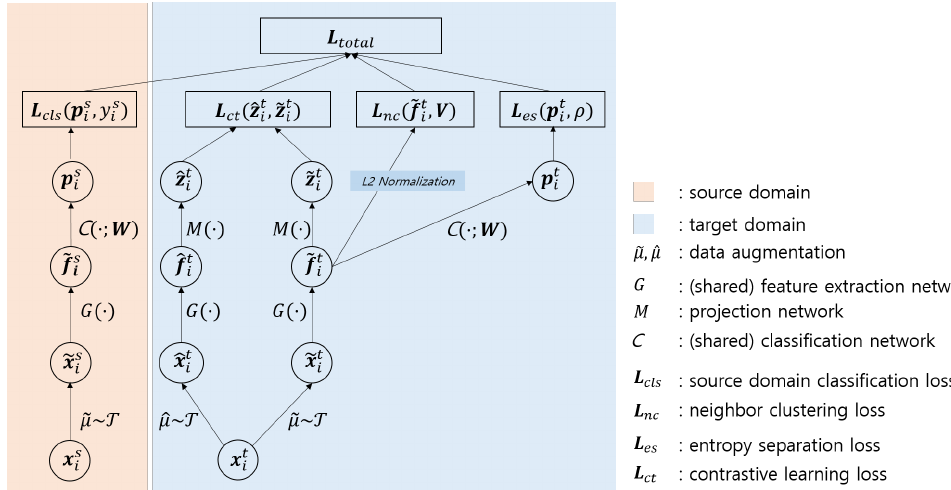
Figure 2. Overview. The proposed method learns a feature representation space considering the discriminative power in both the source ( L cls ) and target ( L ct in Section 3.2.1) domains. The target domain feature is enhanced using contrastive learning, which is an instance-level classification task to overcome the limitations of data synthesis in the source domain and unlabeled target domain data. The remaining losses ( L nc in Section 3.2.2 and L es in Section 3.2.3) cluster class samples and separate known/unknown classes, respectively. Notably, the feature extraction network G is shared in the source and target domains. T denotes the pool of data